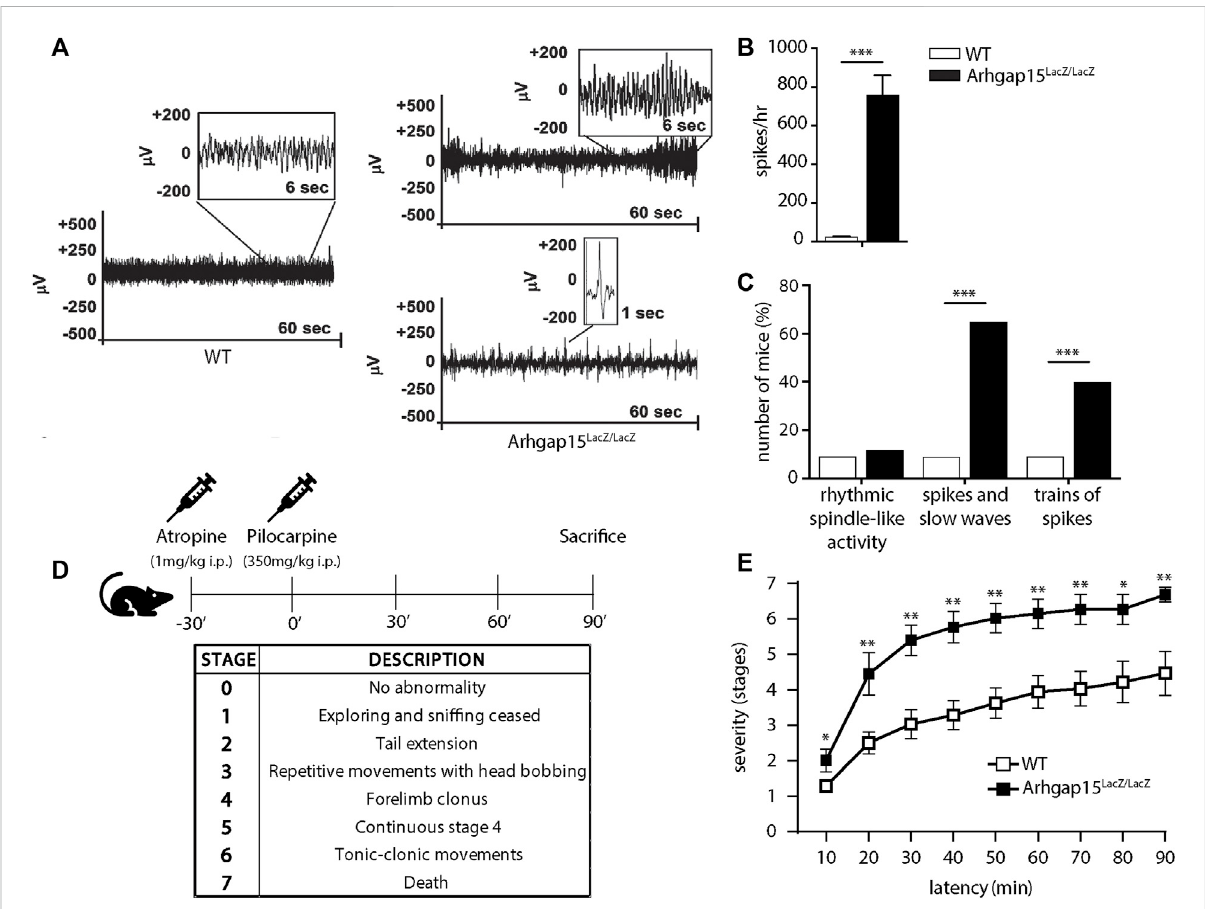
FIGURE 7 Electroencephalography and pilocarpine treatment. (A) Representative electroencephalograms of 1 WT and 2 Arhgap15 LacZ/LacZ mice. For Arhgap15 LacZ/LacZ mice, both trains of spikes (top) and a series of single spikes (bottom) are shown. (B) Average number of spikes per hour in WT and Arhgap15 LacZ/LacZ mice traces. p < 0.0001. (C) Percentage of mice showing rhythmic spindle-like activity (left; p = 0.8), spikes and slow waves (center; p = 0.008), and trains of spikes (right; p = 0.002). n = 10 WT and 8 Arhgap15 LacZ/LacZ mice. (D) Schematic representation of the experimental timeline (top) and a table indicating the stage classi fi cation criteria according to the modi fi ed Racine scale (bottom). (E) Time course of